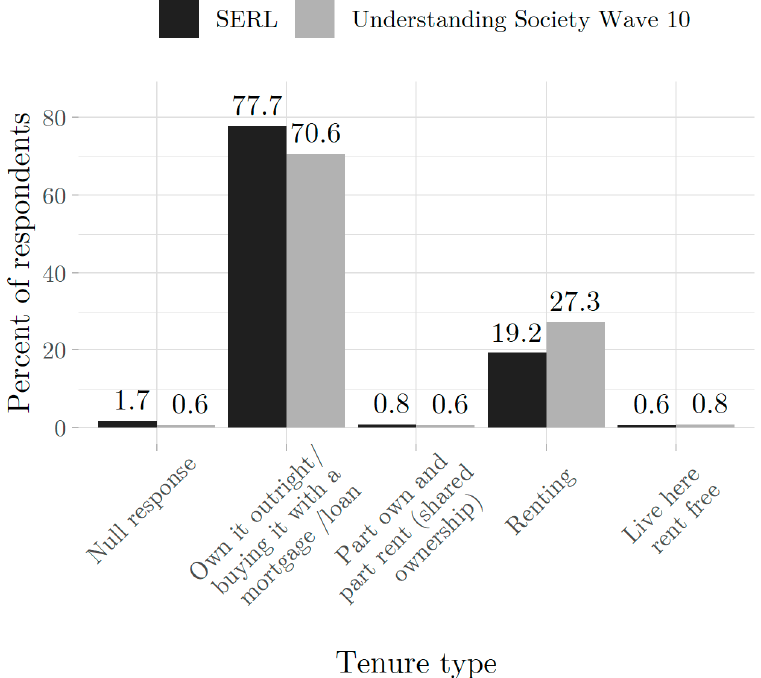
Figure A1. Comparing SERL Observatory tenure types (question B4) with the Understanding Society Wave 10 survey.